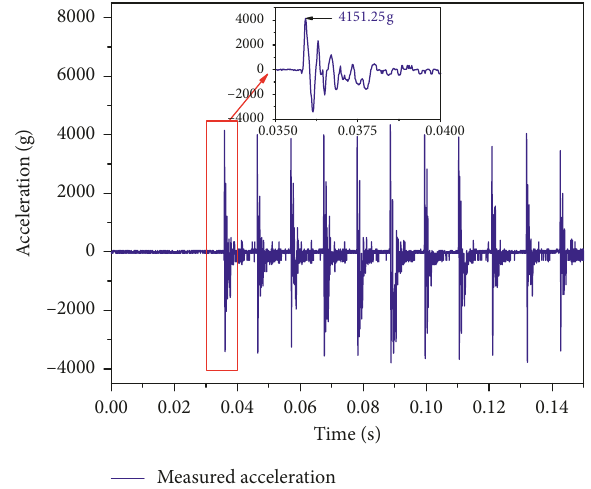
Figure 9: Acceleration of the rigid body overload verification